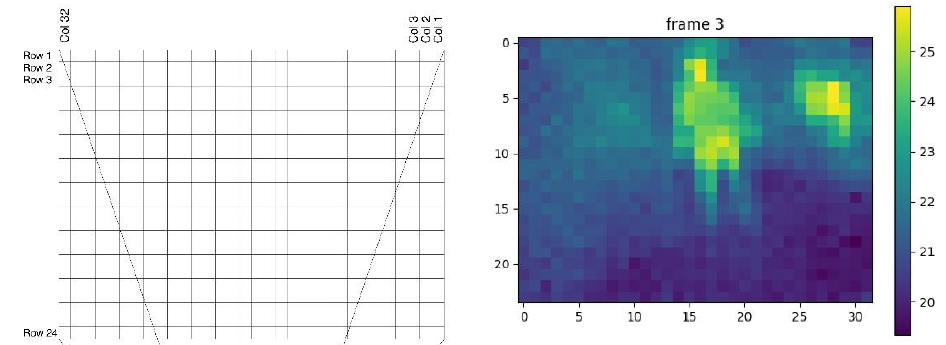
Figure 4. Representation of an image provided by the thermal sensor.